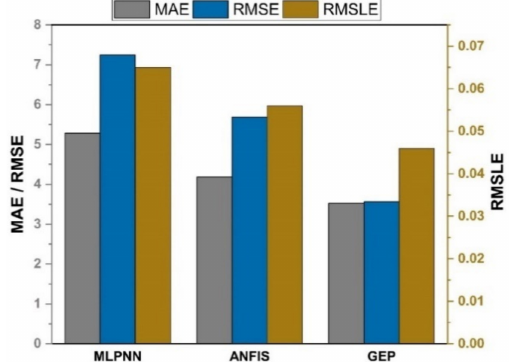
Figure 13. Comparison of errors for compressive strength.